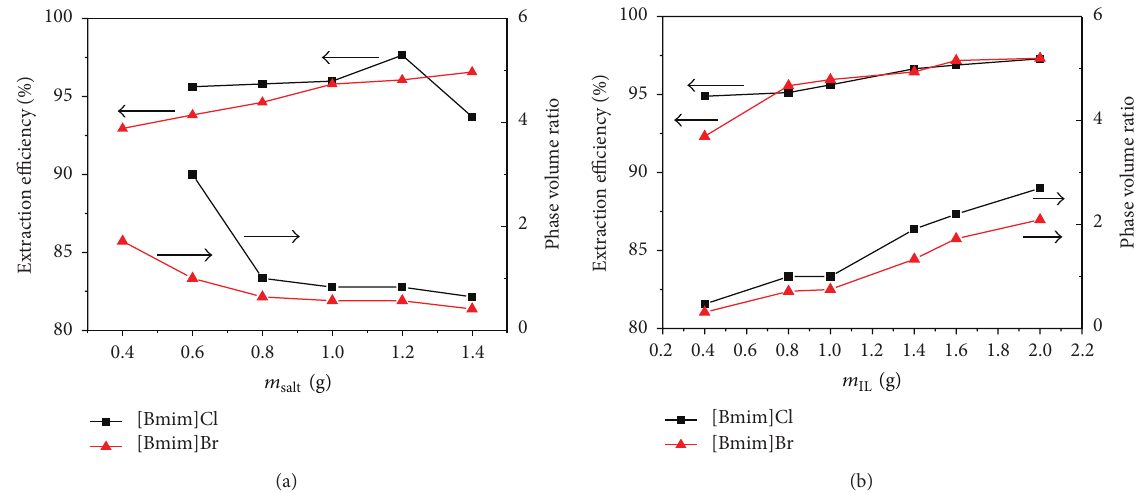
Figure 2: (a) The influence of the amount of K 2 HPO 4 on the extraction efficiency of papain; (b) the influence of the amount of ILs on the extraction efficiency of papain.